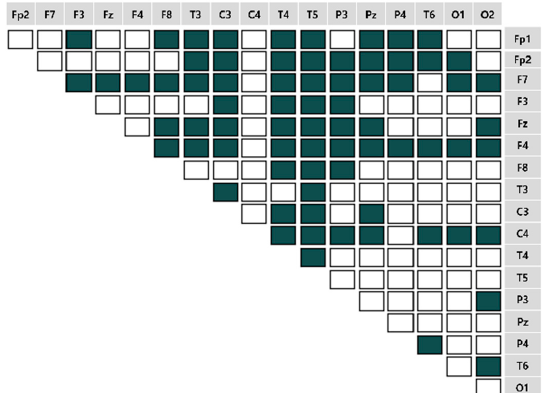
Sensors 2022 , 22 , x Figure 9. The brain connectivity map in the unpleasant-relaxed condition. Figure 9. The brain connectivity map in the unpleasant-relaxed condition. Figure 9. The brain connectivity map in the unpleasant-relaxed condition.